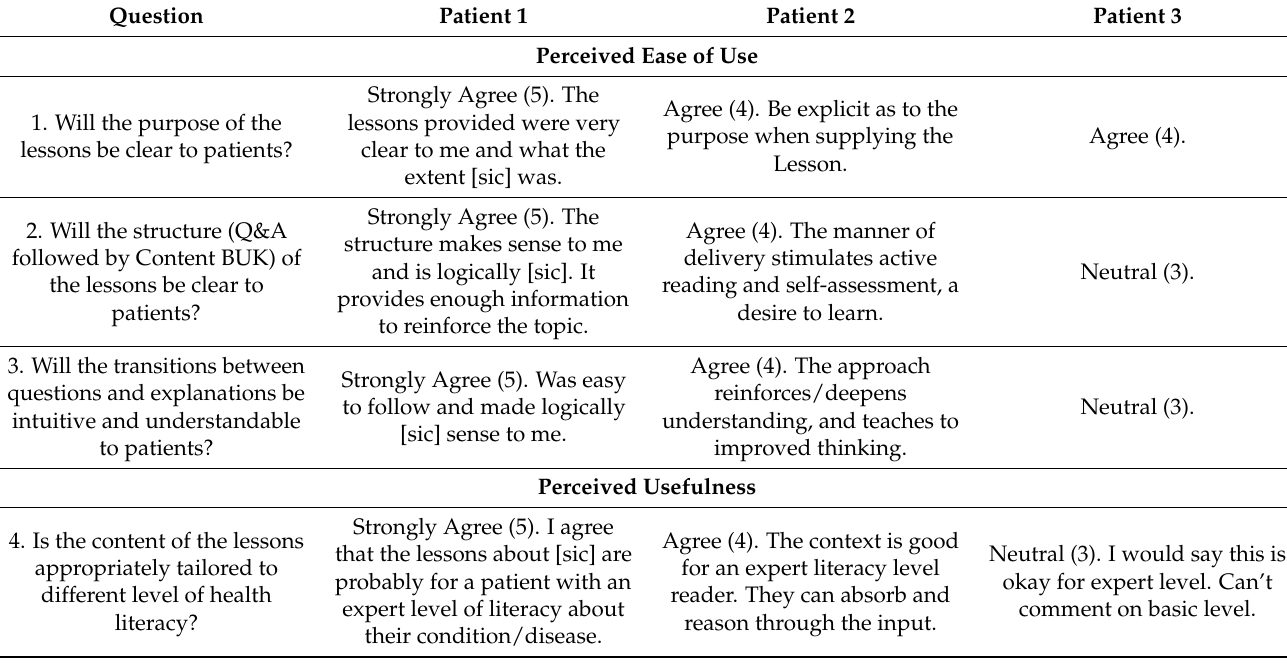
Table A2. User-centered design: feedback received from patient representative end-users’ group for the anticoagulation scenario and a high comprehension